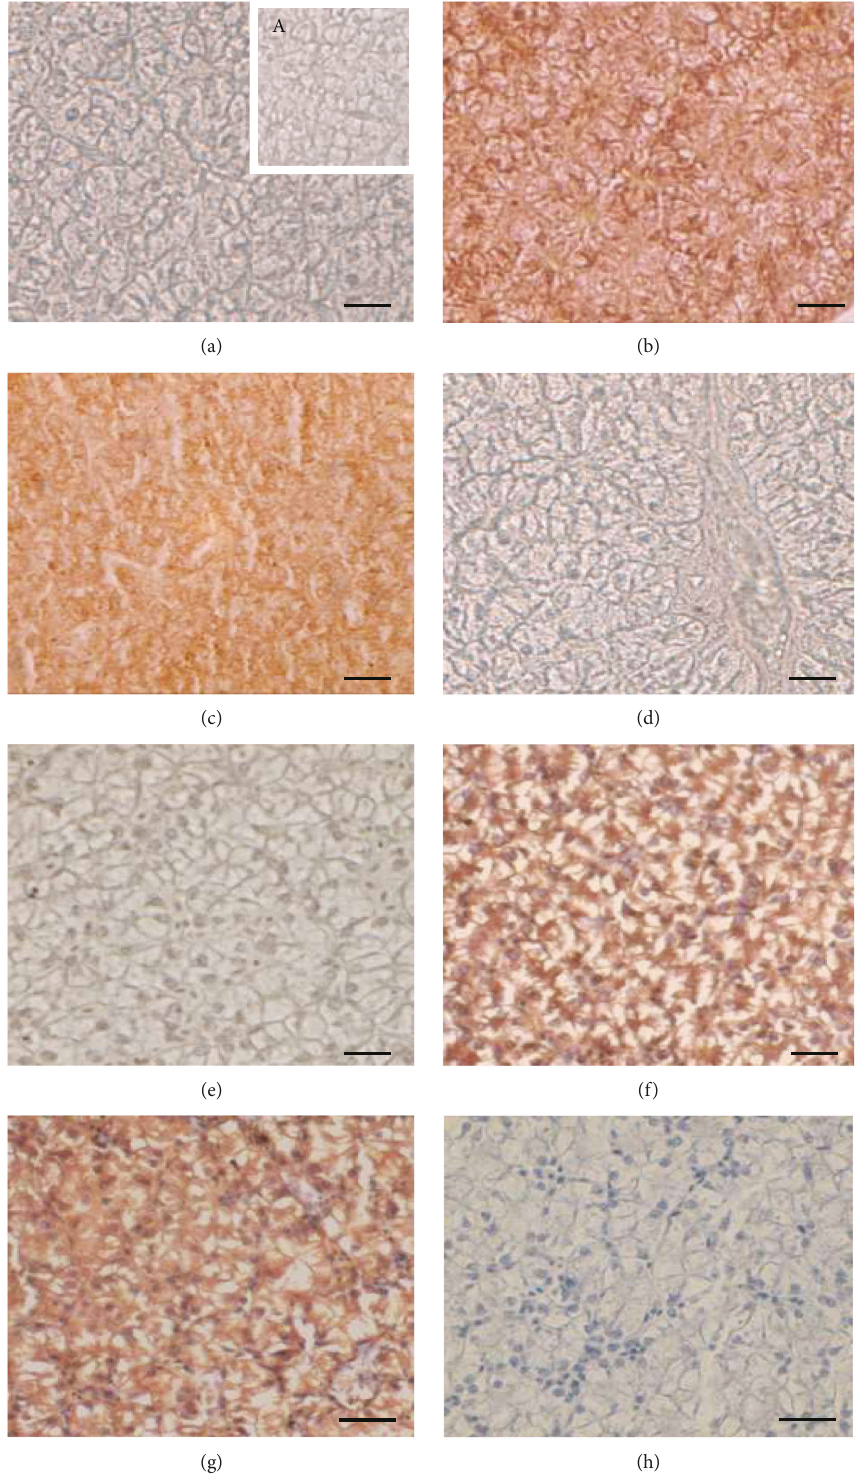
Figure 4: Immunohistochemistry with ER α (a – d) or VTG (bottom panel, e – f) antibodies in the liver. (a) Untreated males: no immunoreactivity is detected to anti-ER α antibody; the box (A) shows the negative control of reaction, performed lacking the antibody. (b) Clomiphene-treated and (c) FSH-treated samples: ir-ER α is evident in cells. (d) FSH-Clomiphene: no immunoreactivity is detected as in untreated samples (a). (e) Untreated males: no immunoreactivity is detected to anti-VTG antibody. (f) Clomiphene-treated and (g) FSH-treated samples: ir-VTG is evident in the cytoplasm cells. (h) FSH-Clomiphene: no immunoreactivity is detected, as in untreated samples (e). In (e), (f), (g), and (h), cell nuclei were counterstained with Mayer ’ s haemalum. The bar is 30 μ